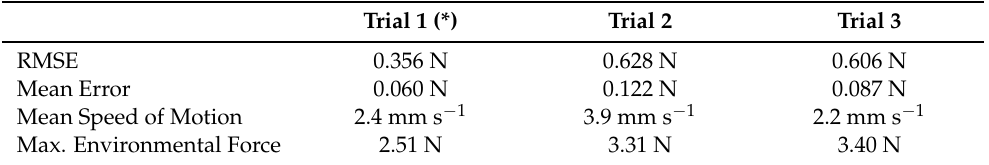
Table 5. RMSE and mean prediction error during palpation using the Kelvin–Voigt virtual environ- ment. Asterisks denote presented experimental